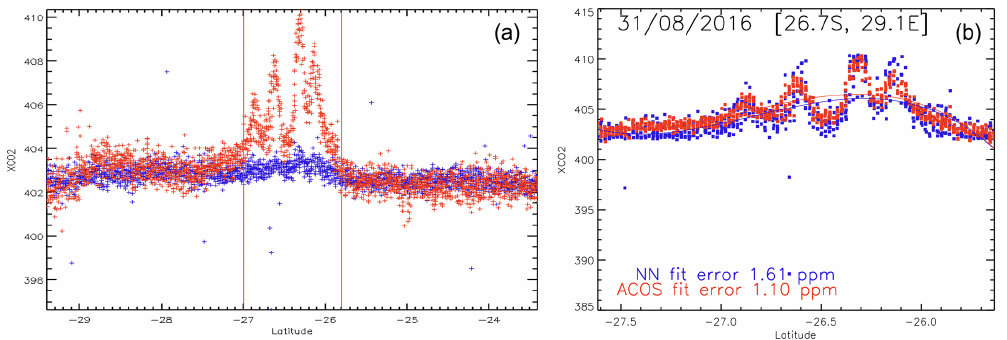
Figure 2. XCO 2 estimated by the ACOS algorithm (red) and the NN approach (blue) as a function of latitude using its initial version as published in David et al. (2021) (a) and the new version presented in this paper (b) . The ACOS product showed a number of XCO 2 enhancements that are not shown by the NN estimates. The plumes are observed downwind of large coal power plants, which make these features trustworthy. The date is 31 August 2016.